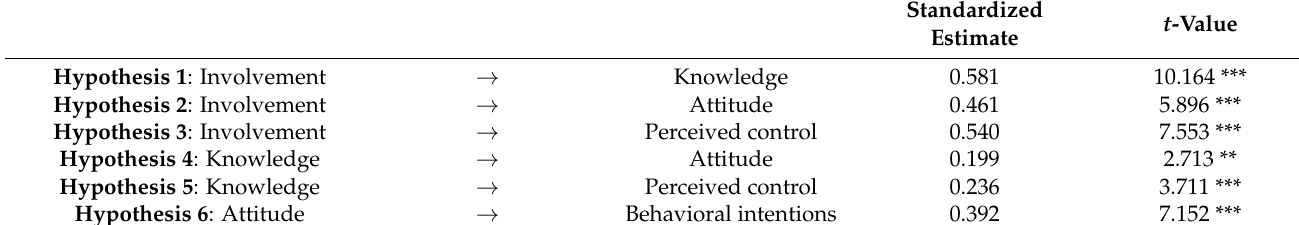
Table 2. Summary of structural equation modeling results.